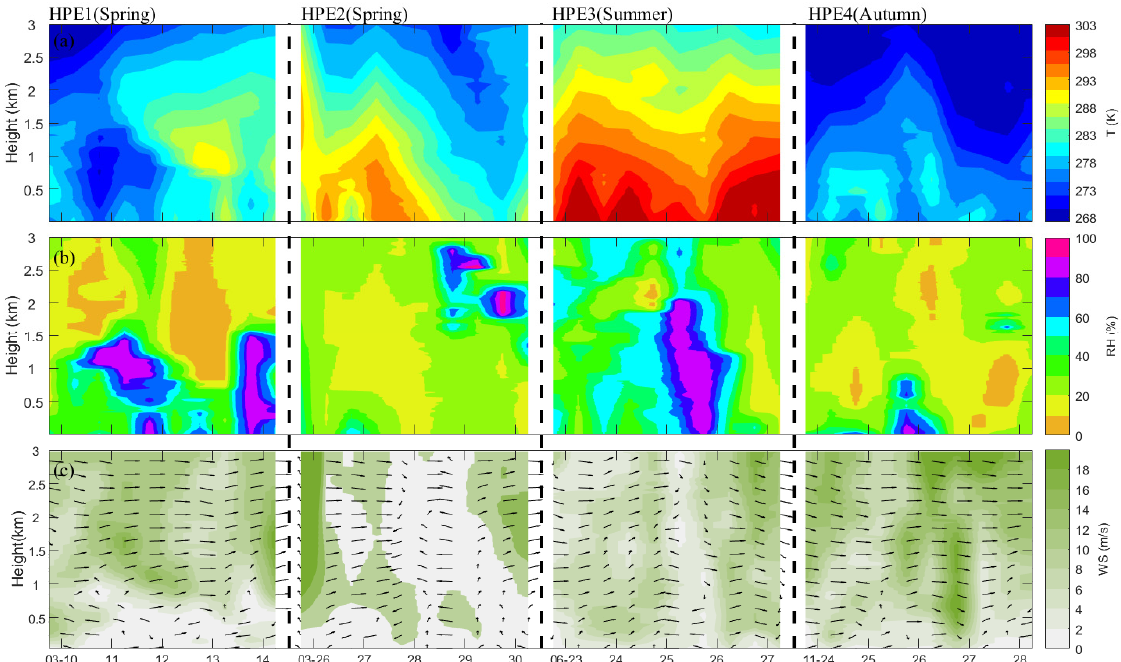
Figure 3. ( a ) Spatiotemporal distribution of temperature (shading; unit: K); ( b ) RH (shading; unit: %) and ( c ) wind vector and velocity (shading; unit: m s − 1 ) during heavy pollution episodes (HPE1, 2, 3, and 4) in Beijing in 2018.